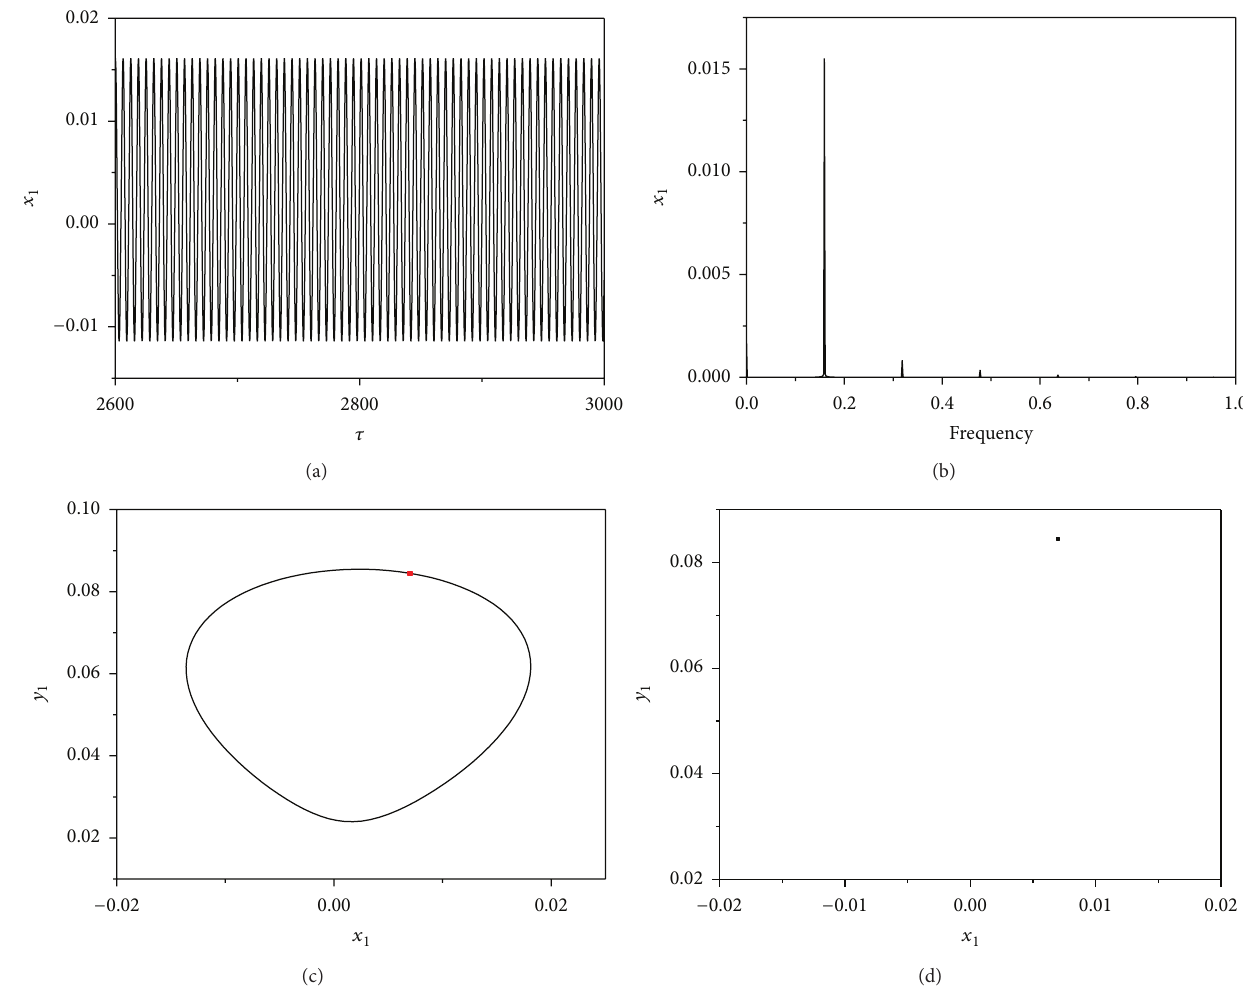
Figure 5: See 𝜔 = 0.65 . (a) Displacement response. (b) Frequency spectrum. (c) Rotor orbit. (d) Poincar´e maps.